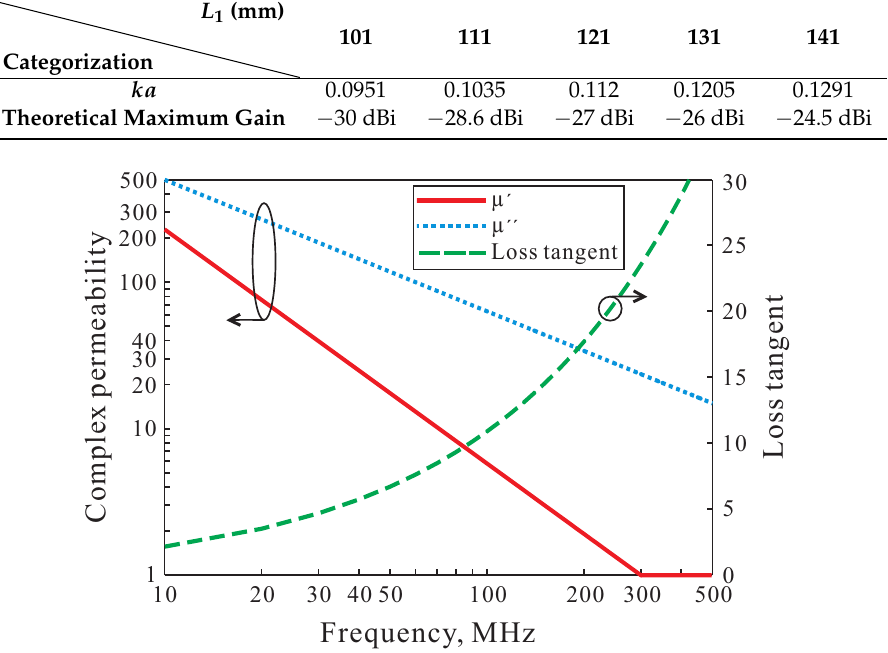
Figure 2. Complex permeability and magnetic loss tangent properties of the SN-20